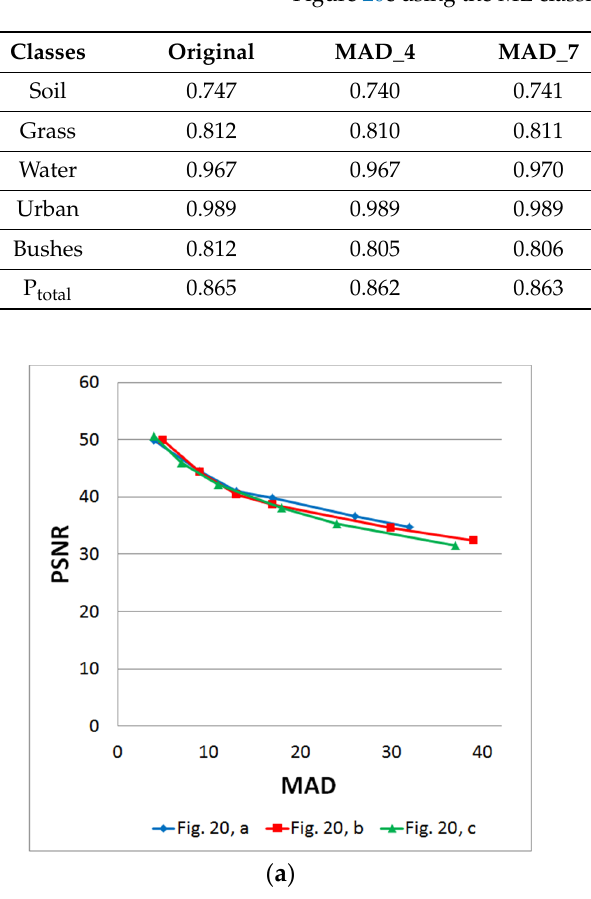
Figure 21. Results of compression by DAC with DAT of the depth 2 of test images, shown in Figure 20: dependence of PSNR on MAD ( a ), the dependence of CR on PSNR ( b ).